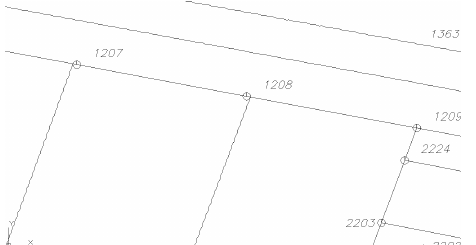
Figure 7. Example for rotated lines (Leopoldseder, 2015, p. 52, data: © BEV)